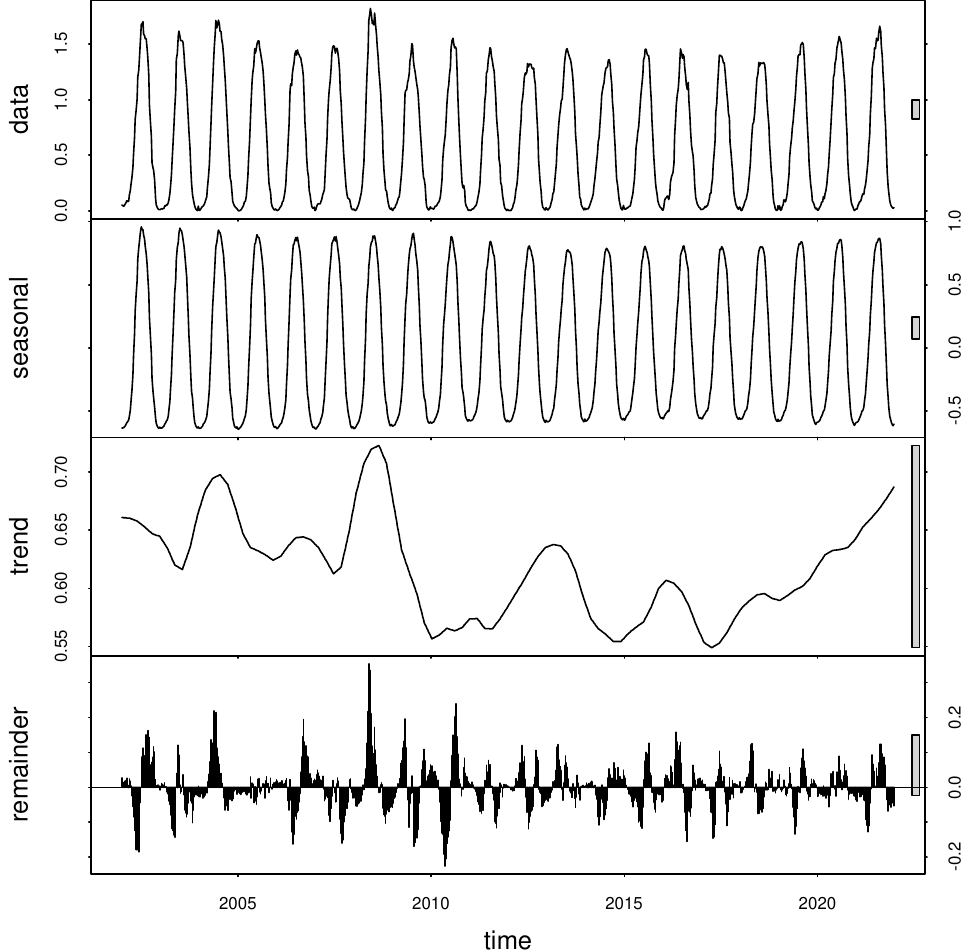
Figure 7. Characteristics of WUE changes during 2002–2021.